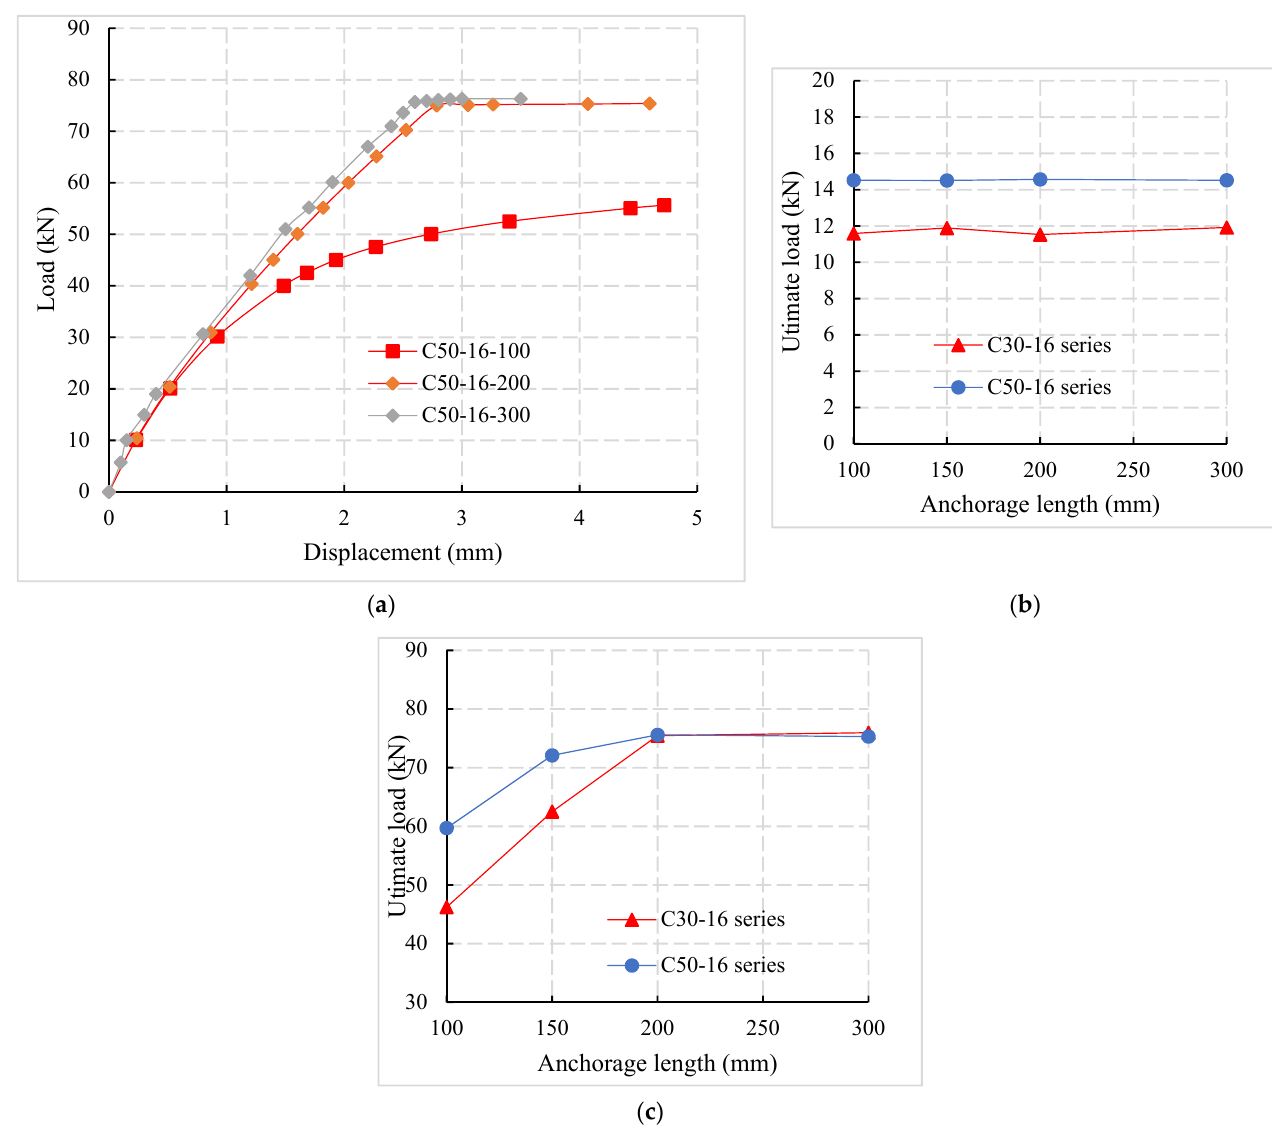
Figure 14. Influence of anchorage length. ( a ) Load-displacement curves for anchorage lengths. ( b ) Bond strength and anchorage length. ( c ) Relationship b/w ultimate load and anchorage length.